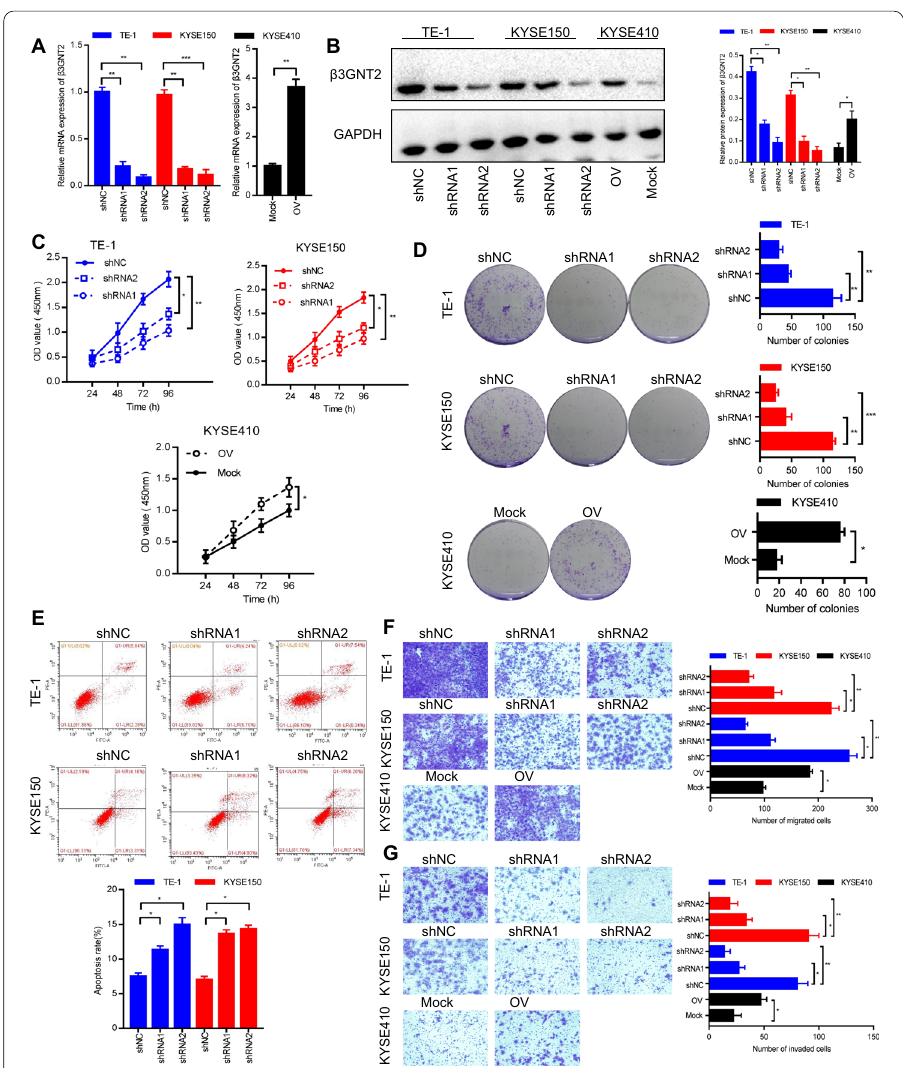
Fig. 3 β3GNT2 promotes ESCA cell growth, migration, and invasion in vitro. A Analysis of β3GNT2 mRNA expression by qPCR. B Analysis of β3GNT2 protein expression by Western blot. C Cell proliferation was determined by the CCK-8 assay. D Colony formation ability was measured by colony formation assay. E Cell apoptosis was assessed by flow cytometry. F Cell migratory potential was analyzed by Transwell migration assay. G Cell invasion capacity was detected by Matrigel invasion assay. Cells were transfected with the indicated plasmids. shNC, negative control shRNA; shRNAs, β3GNT2 shRNA lentiviral vector; Mock, empty plasmid; OV, pcDNA3.1/β3GNT2 plasmid. Data are expressed as mean SD. *P < 0.05; **P < 0.01; ***P < ±